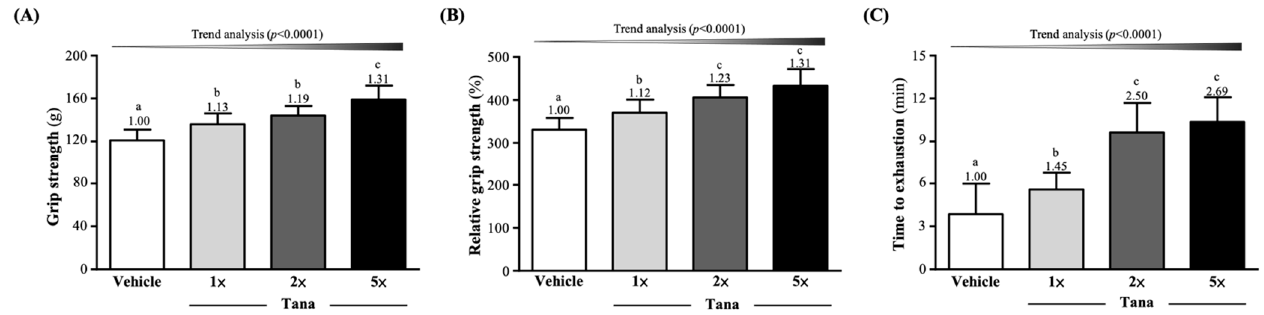
Figure 2. Effect of 4 weeks of Tana supplementation on ( A ) absolute forelimb grip strength, ( B ) relative forelimb grip strength, and ( C ) exhaustive swim time. Data are expressed as mean ± SD for n = 10 mice per group. Different superscript letters (a, b, c) indicate significant difference at p <